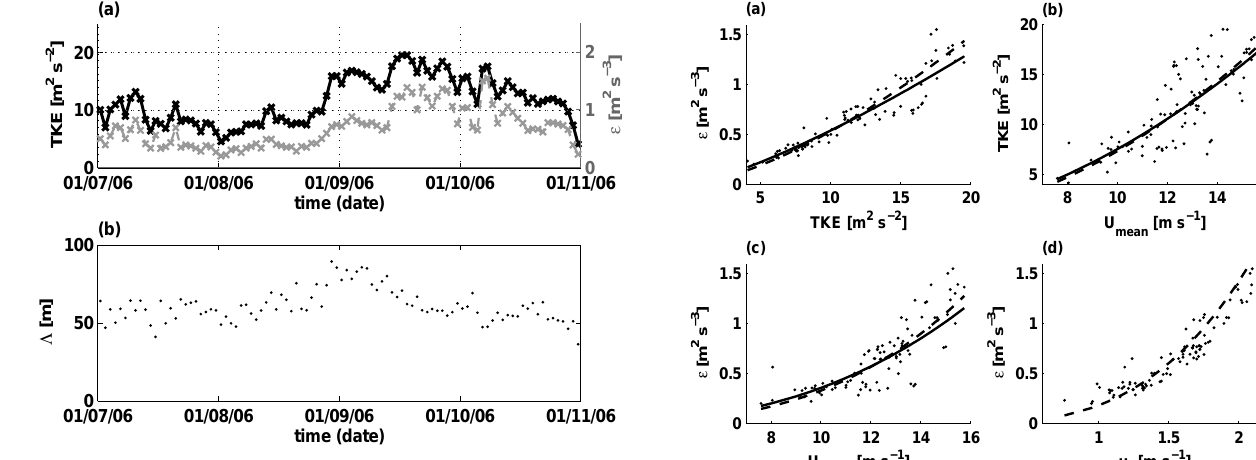
Fig. 7. (a) Time evolution of TKE (black marks) and ε evaluated by IDM (grey marks), and (b) time evolution of the empirical length scale parameter 3 estimated from Eq. (3) during the entire 4 day bora episode.